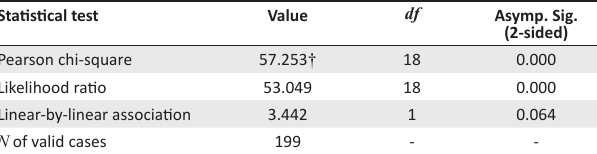
TABLE 2b: Correlation between level of functioning and influence on performance and careers as in Table 2a. Statistical test